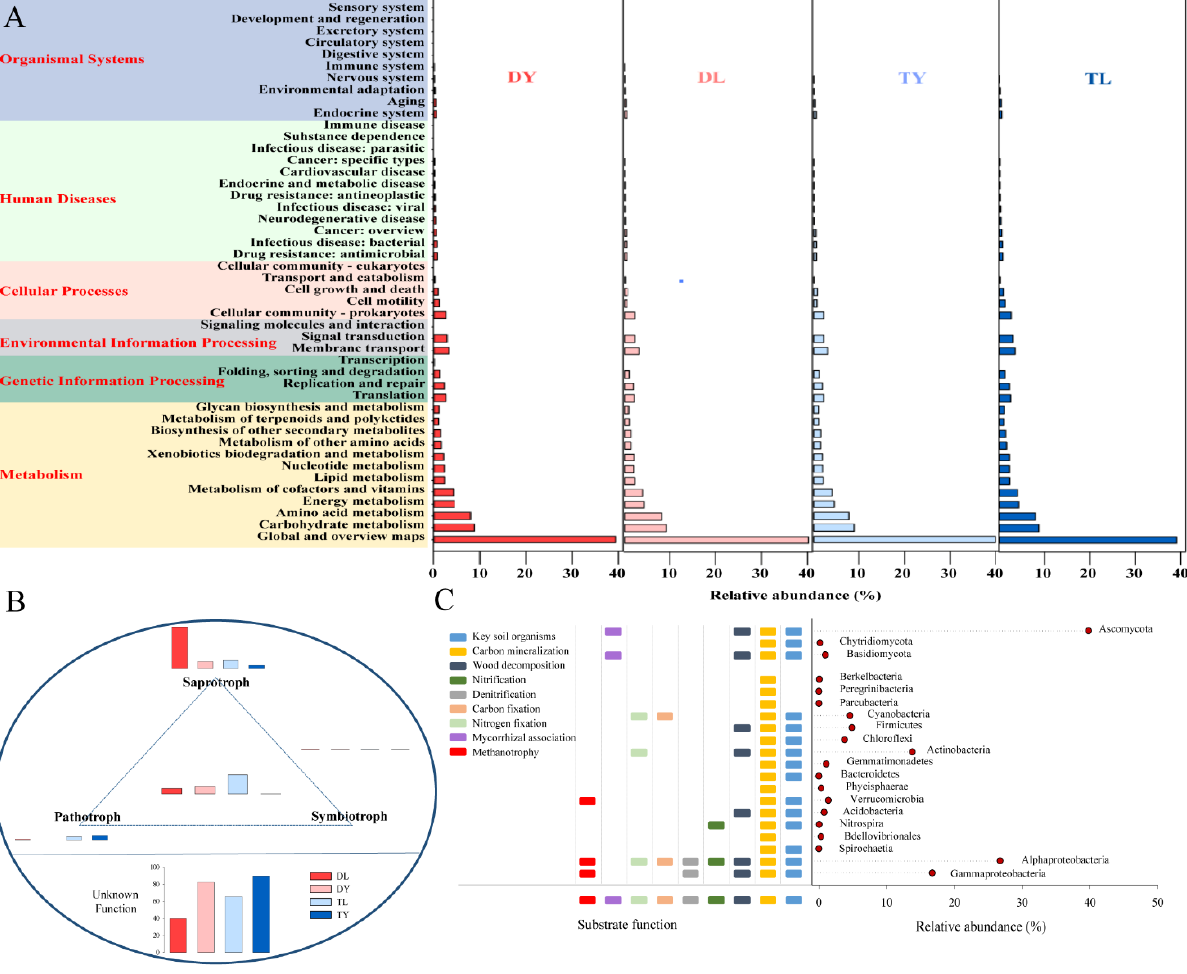
Figure 4. Function prediction of microbial communities for soilless growing media. ( A ) Bacterial functional profiles; ( B ) fungal functional profiles; ( C ) common functional profiles.